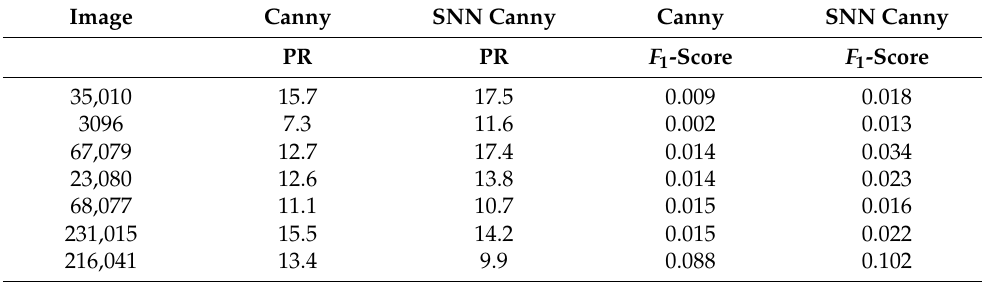
Figure 6. A comparison of edge detection by Sobel, Canny, and SNN Canny edge detectors for medical images from CT emphysema dataset. Table 1. Comparison of performance ratio, PR, and F 1 -score for selected images.